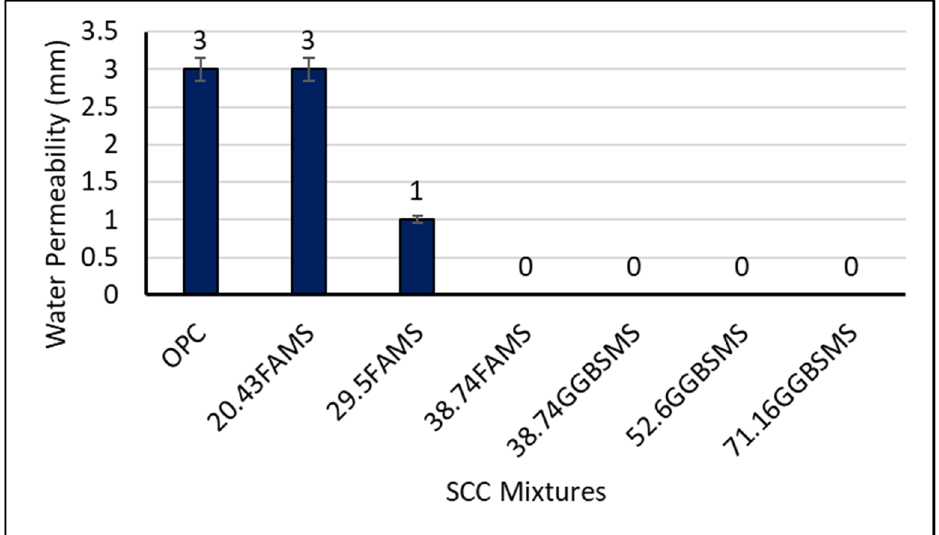
Figure 15. Water penetration depth of SCC mixtures at 28